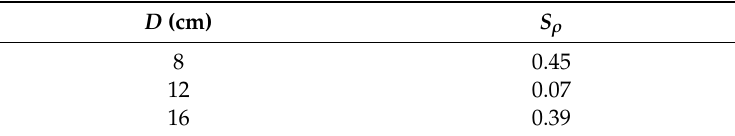
Figure 9. Effect of distance from the apex of partition plate to the backplane on the average density of particles in the bed. ( a ) D = 8 cm; ( b ) D = 12 cm; ( c ) D = 16 cm. Table 6. S ρ for different values of D.